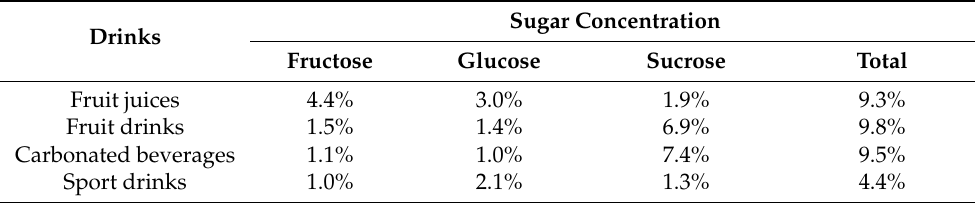
Table 1. Sugar content of fruit juices, fruit drinks, carbonated beverages and sport drinks